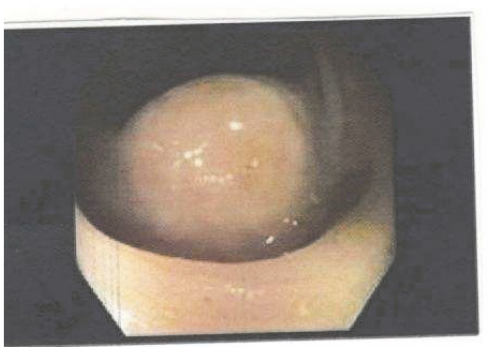
Figure 1: Nodular area in transverse colon.